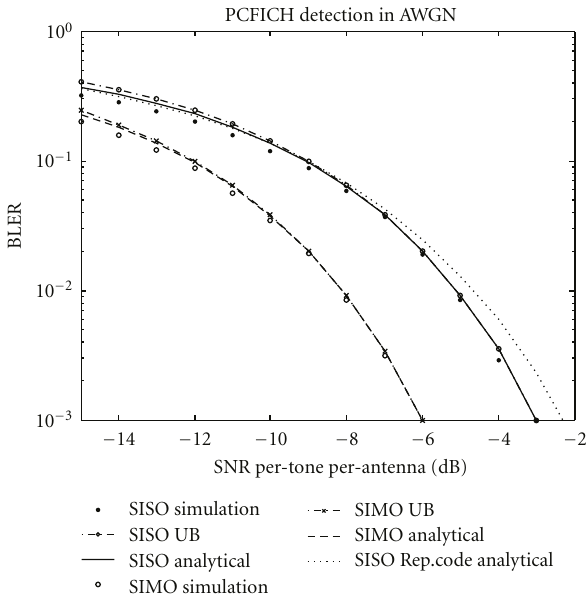
Figure 1: PCFICH performance in AWGN.